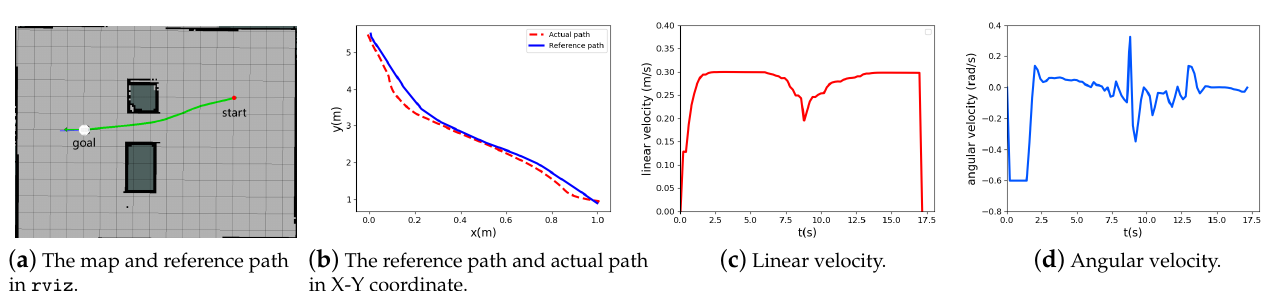
Figure 12. The performance of the whole framework in a scenario with few obstacles and a narrow channel.